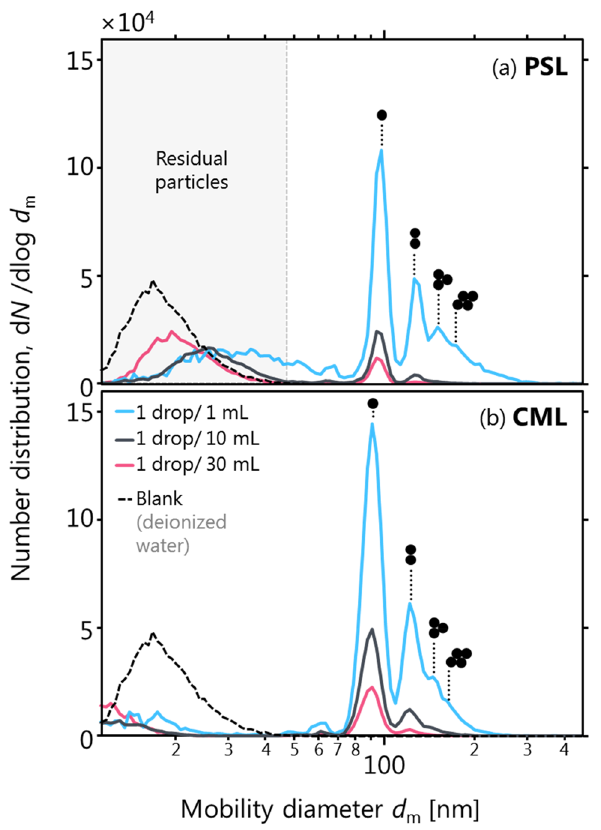
Figure 4. Residues (< 60 nm mobility diameter particles) and multimers (> 100 nm mobility diameter) of PSL suspensions add complexity to aerosols of ostensibly monodisperse particles. Doublets are present even for dilute mixtures. Panel ( a ) shows PSL with surfactant added to minimize coagulation, Panel ( b ) shows CML (PSL with surface-bonded carboxylate groups instead of